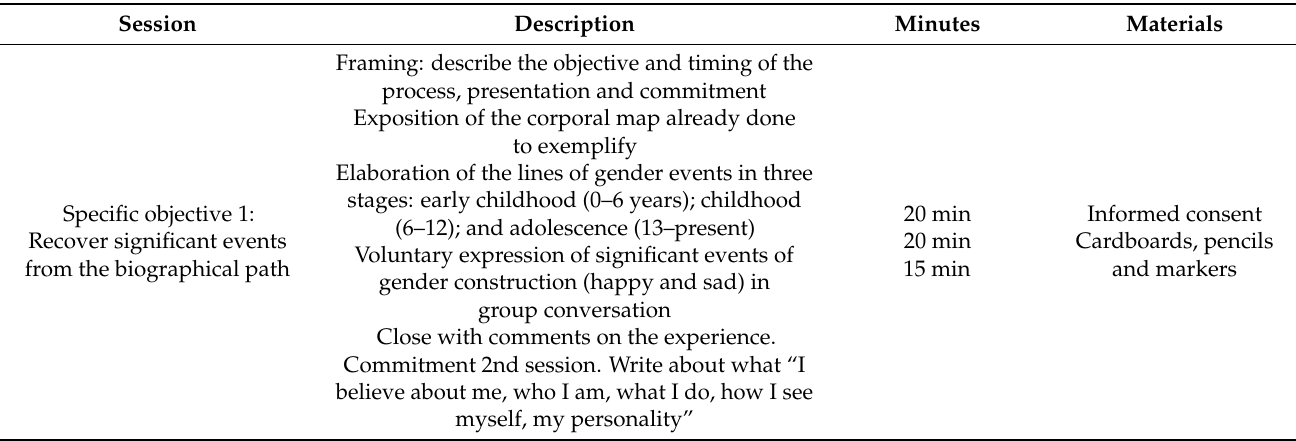
Table 1. Workshop planning